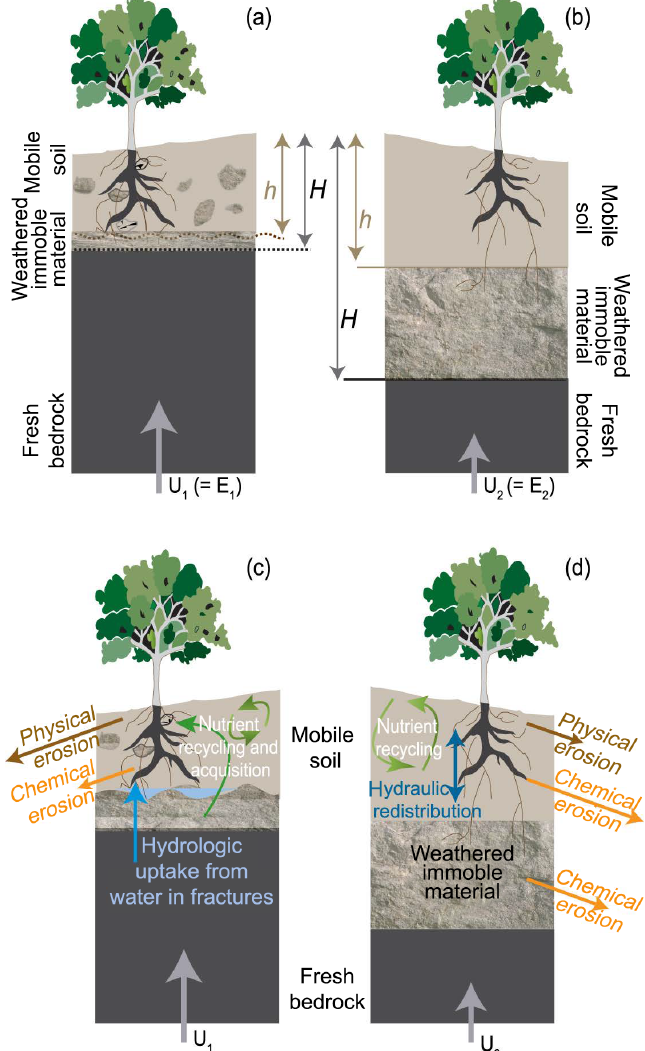
Figure 2. Conceptual model for two end members of steady-state forested profiles such that uplift rates ( U ) equal erosion rates ( E ): (a, c) where trees profoundly influence architecture and plumbing processes in the critical zone ( h ∼= H ) and (b, d) where trees may amplify or modulate critical zone processes; however, they do not influence the deeper architecture ( h (cid:28) H ). Upper figures emphasize architectural differences, whereas lower figures describe differences in processes and erosion rates. We posit that the ratio of the thickness of the mobile layer ( h ) to that of the entire layer of weathered material ( H ) – both immobile and mobile – is set by the balance between erosion and weathering processes. When U and E are rapid (i.e., U 1 > U 2 ; E 1 > E 2 ), tree roots not only set the boundary between the mobile and immobile layers, but through growth and turnover can also impart a “wavy” boundary, and can inject detached fresh rock and mineral material in a range of sizes into the mobile soil layer by wind sway, growth-driven root actions, and tree throw (a) . This contrasts with a slower uplift and erosion rate (e.g., U 2 ) where roots are predominantly contained within the mobile soil layer, the interface between immobile and mobile material is generally less wavy, and grains of material injected from below into the mobile soil are generally finer and more weathered than in a fast-eroding setting (b) . When the h/H ratio ∼= 1, physical erosion likely dominates over chemical erosion, both of which are restricted essentially to h . In this regime, root fungi acquire nutrients from both recently detached grains in the mobile layer and, to a lesser extent, from fresh bedrock (c) . In contrast, when h (cid:28) H , chemical erosion dominates in both the mobile and immobile layers and root fungi are restricted mainly to merely recycling material within the mobile soil layer, with only a small influx of nutrients from the much lower density of roots extending into the deeper immobile material below (d) . The difference in architecture potentially influences subsurface hydrologic routing and storage: when h ∼= H , the wavy interface at the boundary of mobile and immobile material promotes opportunities for “fill and spill” (water ponded in depressions as shown in blue), while fractures store water that is accessible for root uptake. In contrast, when h exceeds the depth of penetration of most tree roots as in (d) , the architecture may not promote opportunities for “fill and spill” nor for water in fresh bedrock to be important as a source for trees. While hydraulic redistribution could happen in both end members, we show it in (d) to emphasize that most roots in this end member do not access fracture-held water in fresh